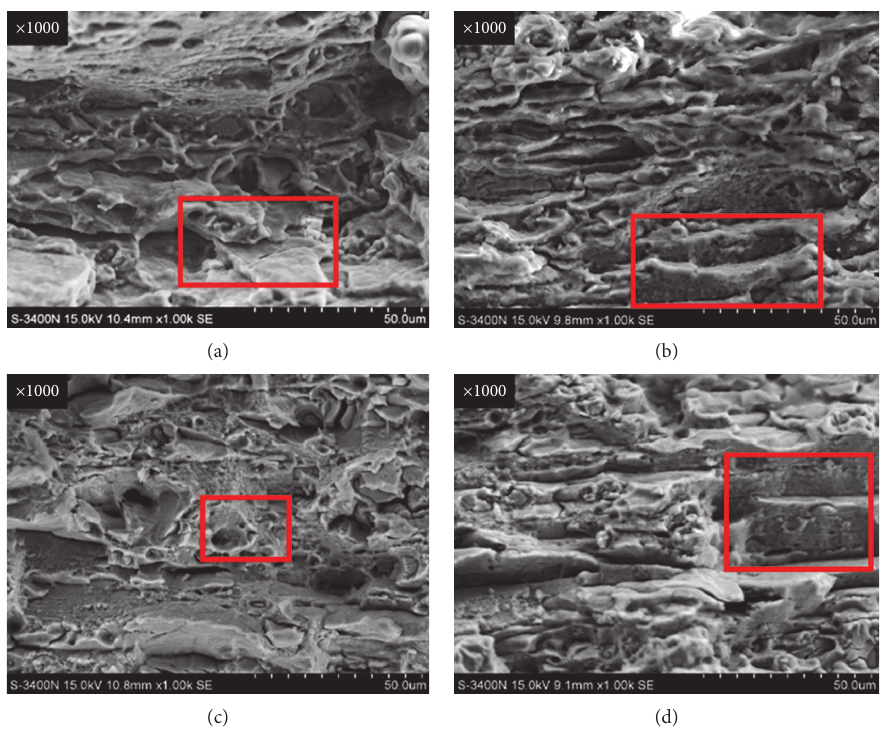
Figure 4: SEM images of the fracture morphology ( × 1000): (a) without inhibitor. (b) 0.5 g/L SDBS. (c) 7.5g/L sodium succinate. (d) 0.6g/L new corrosion